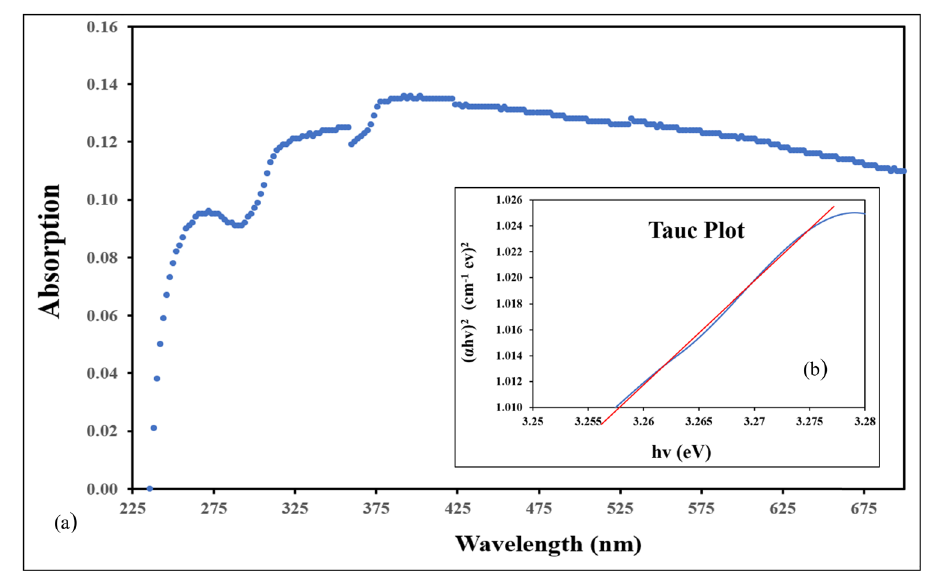
Figure 5: UV - Vis Absorption spectra: ( a ) ZnO NSs and ( b ) Tauc plot of ZnO NSs.